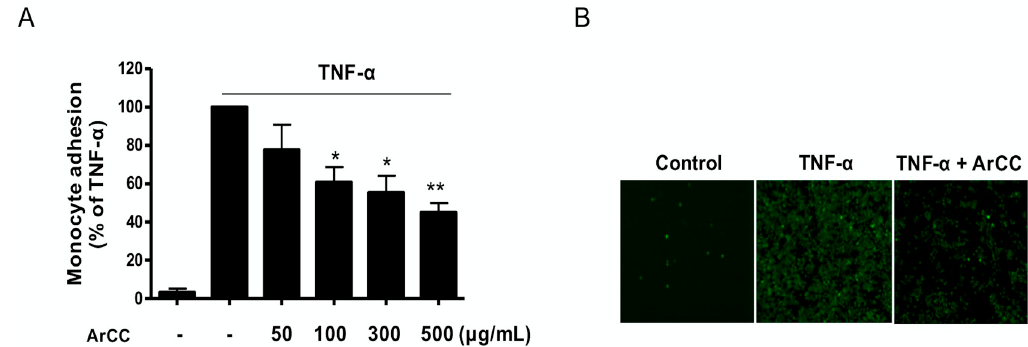
Figure 4. ArCC treatment inhibits monocyte adhesion on TNF- α -stimulated HUVECs. HUVECs were pretreated with ArCC for 1 h, followed by treatment with TNF- α for 18 h. Fluorescent probe-labeled U937 monocytes were added onto the TNF- α -stimulated HUVECs and then incubated for 2 h. ( A ) The number of U937 cells adhering to the HUVECs was determined using a fluorometer. ( B ) Adherent U937 cells observed using a fluorescence microscope at 200 × magnification. Data are representative of three independent experiments. Results are presented as means ± SEM ( n = 3). * p < 0.05, ** p < 0.01 compared with TNF- α -treated group as determined by one-way analysis of variance followed by Bonferroni’s multiple comparison tests.